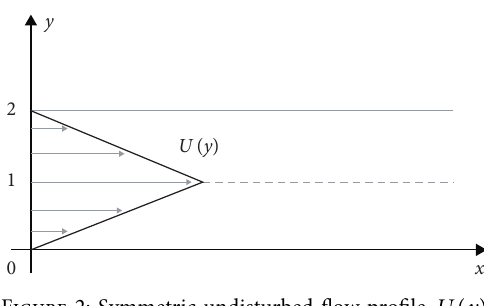
Figure 2: Symmetric undisturbed flow profile, U ( y )